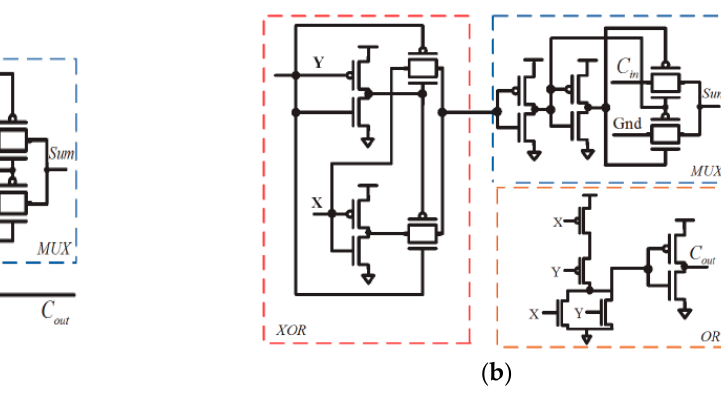
Figure 5. TGA1 ( a ) and TGA2 ( b ) full adders.